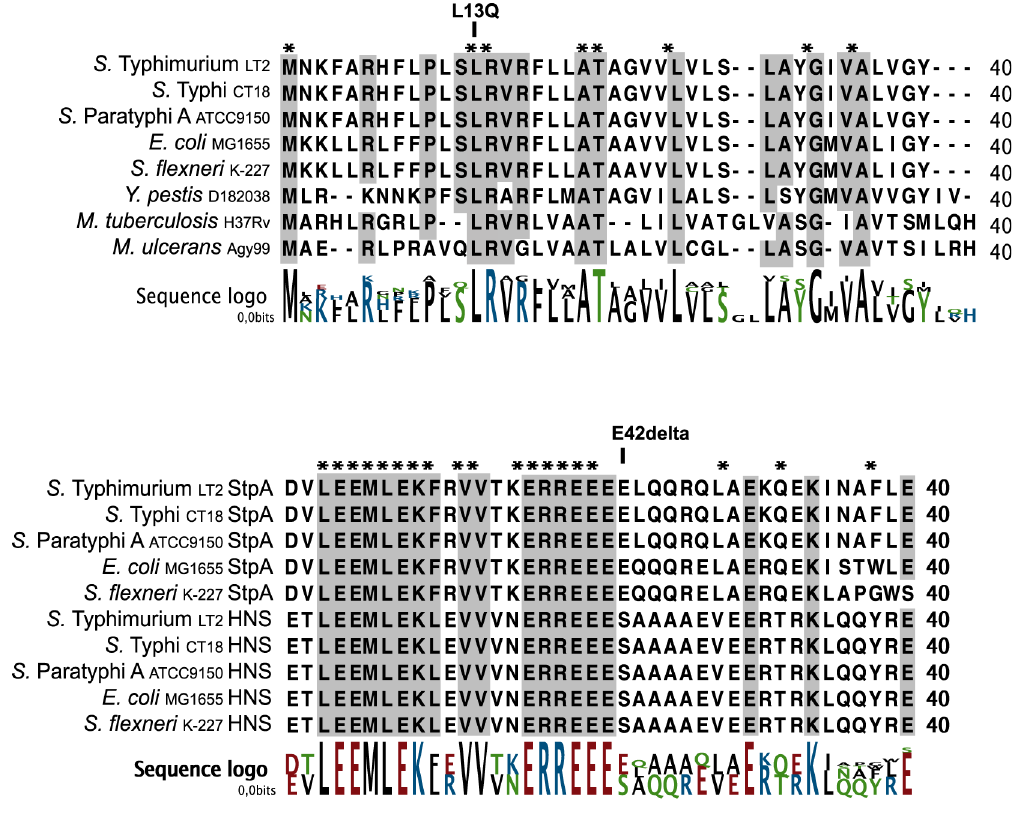
Figure 2. Pathoadaptive phoQ (L13Q) and stpA (E42delta) mutations are not found in previously sequenced strains. Multiple alignment of PhoQ (top) and StpA and HNS (bottom) proteins from all published Salmonella sequences and other organisms as indicated.